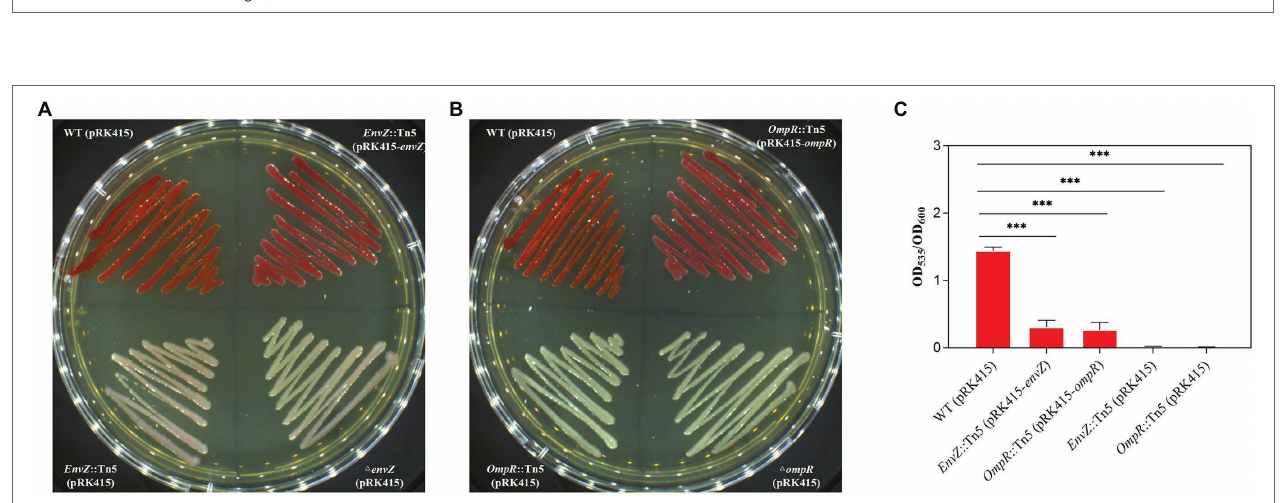
FIGURE 3 | Functional certification of EnvZ and OmpR on prodigiosin-producing ability by gene knockout and complementation. (A) The complementary strain EnvZ ::Tn5 (pRK415- envZ ) was constructed by transferring the pRK415- envZ plasmid with a tetracycline-resistant gene into the mutant envZ ::Tn5 strain. The wild- type (WT) strain, Tn5-inserted envZ ::Tn5 mutant and gene knockout Δ envZ strain were transfected with pRK415 to confer tetracycline resistance and used as controls. (B) The complementary ompR ::Tn5 (pRK415- ompR ) was constructed by transferring pRK415-ompR into the ompR ::Tn5 strain. The other three strains were similar to those described in (A) . (C) Prodigiosin producing ability of WT (pRK415) strain, complementary strain envZ ::Tn5 (pRK415- envZ ), complementary strain ompR ::Tn5 (pRK415- ompR ), mutant strain envZ ::Tn5 (pRK415), and ompR ::Tn5 (pRK415). Means ± SDs from three independent experiments are shown. Significant differences in prodigiosin producing ability relative to the related strains/WT by unpaired t -test are shown as follows: *** p < 0.001. All the strains were incubated on LB agar with tetracycline (50 mg/L) at 28 ° C for 36 h.